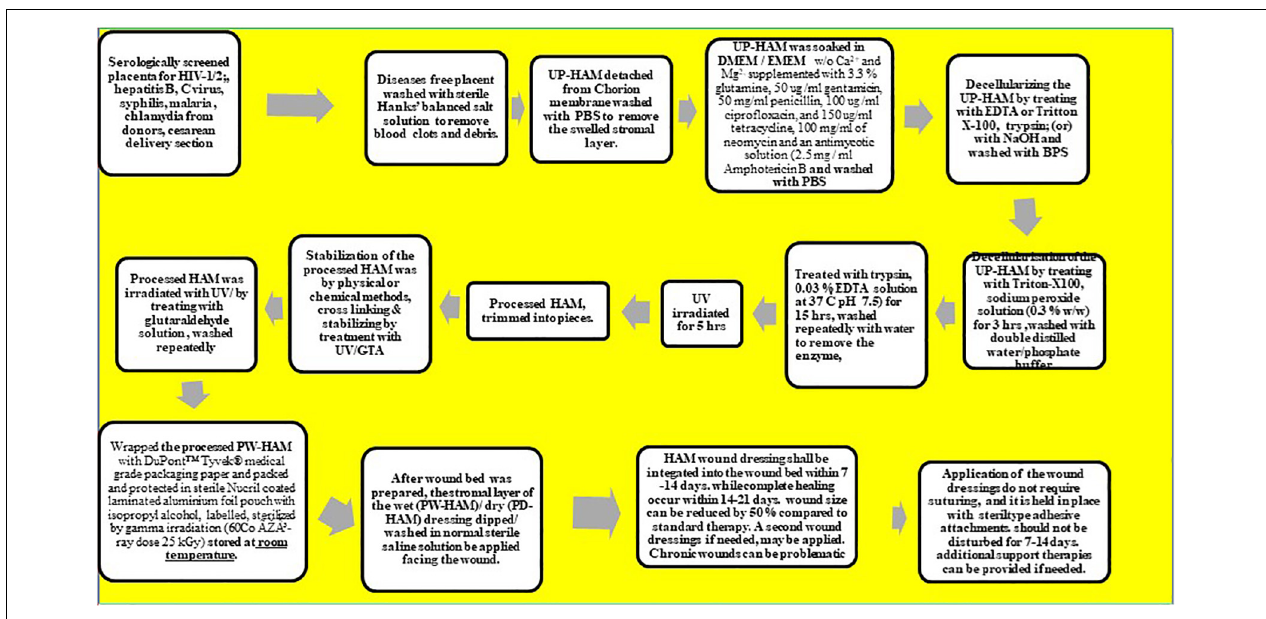
FIGURE 1 | Flow chart shows the processes and preparation of HAM and